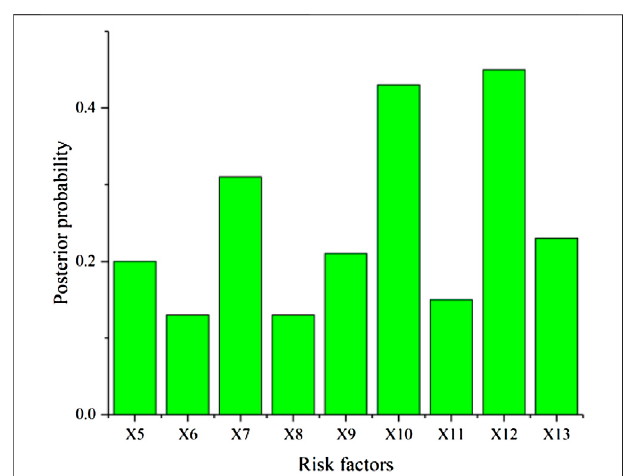
FIGURE 9 | Fault diagnosis in the safety control of a tunnel